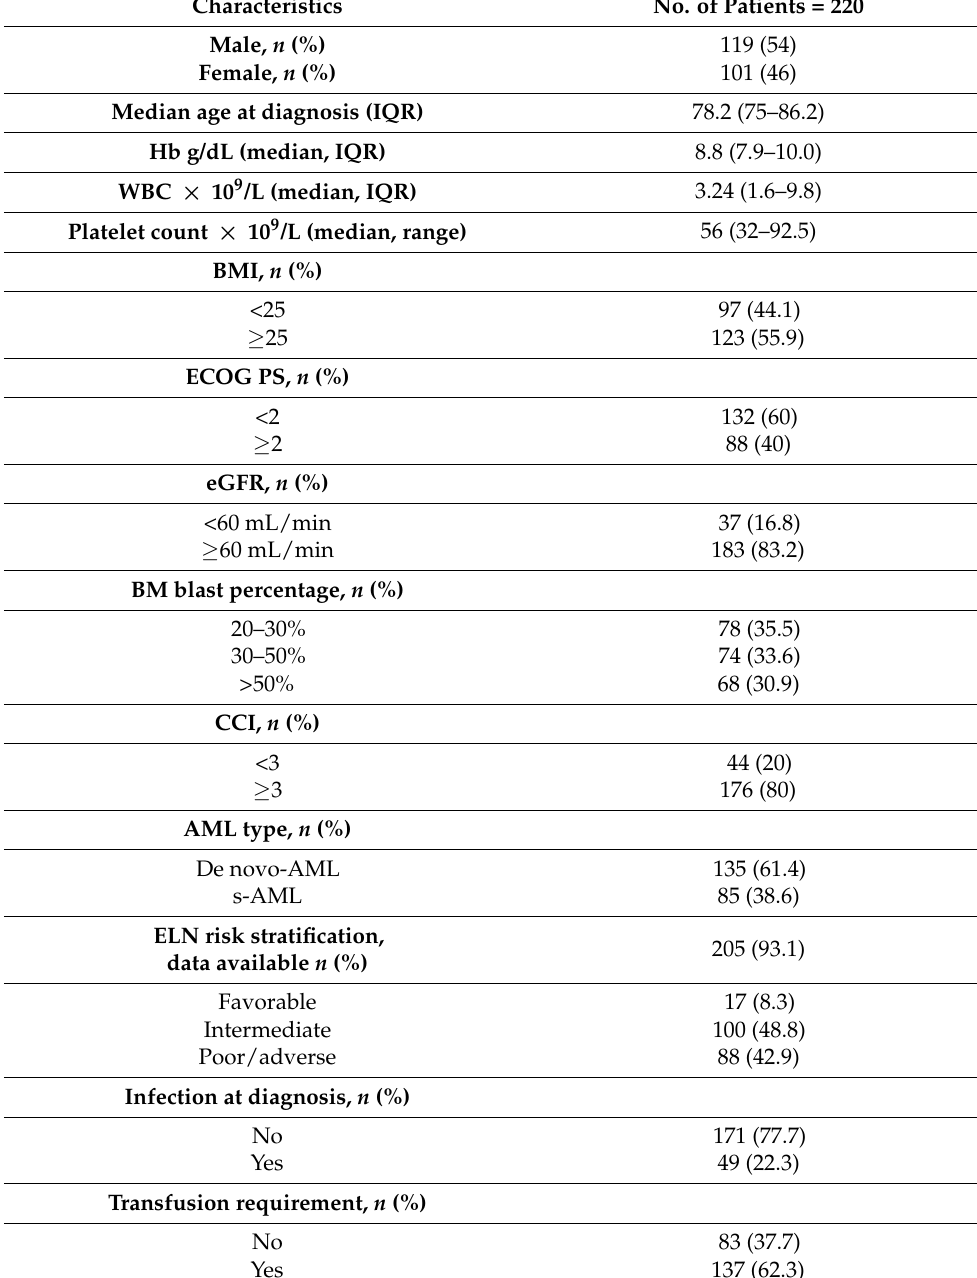
Table 1. Baseline characteristics of